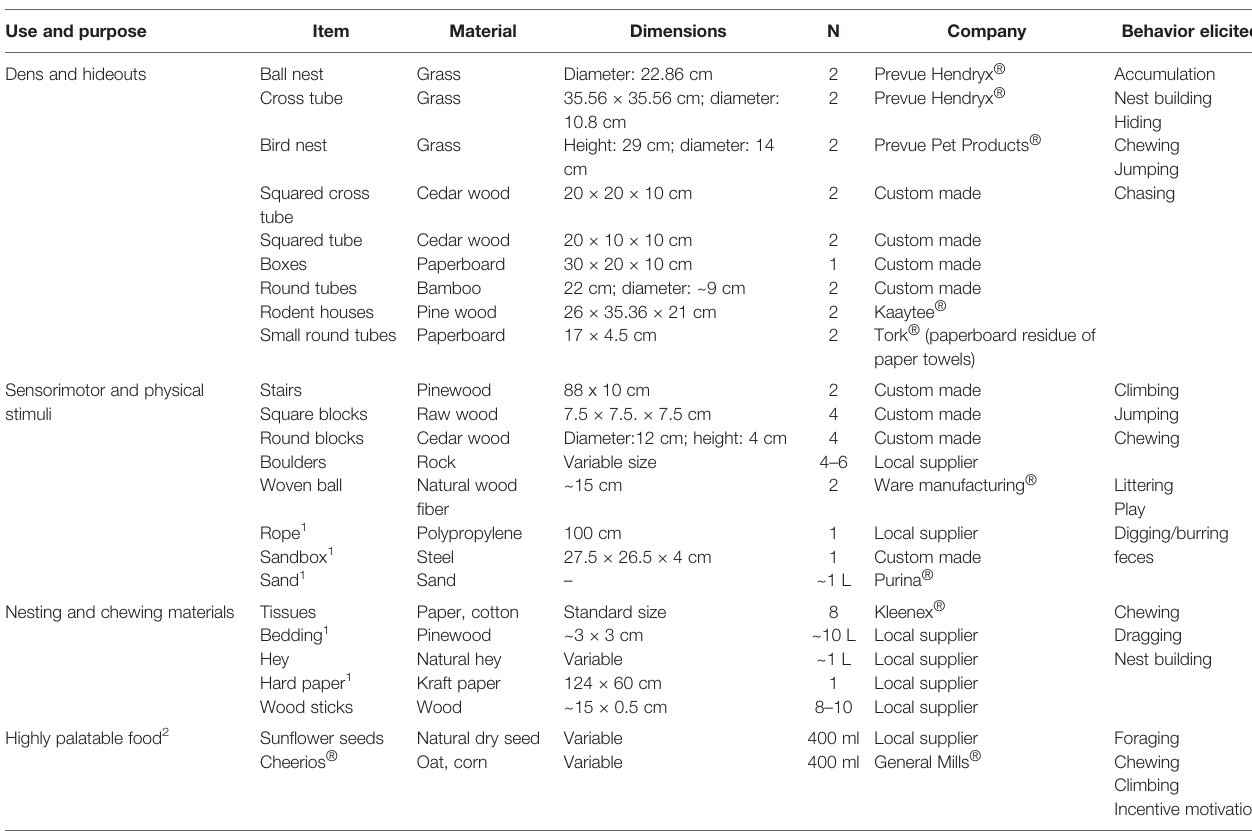
TABLE 1 | A detailed description of the items used for environmental enrichment. Use and